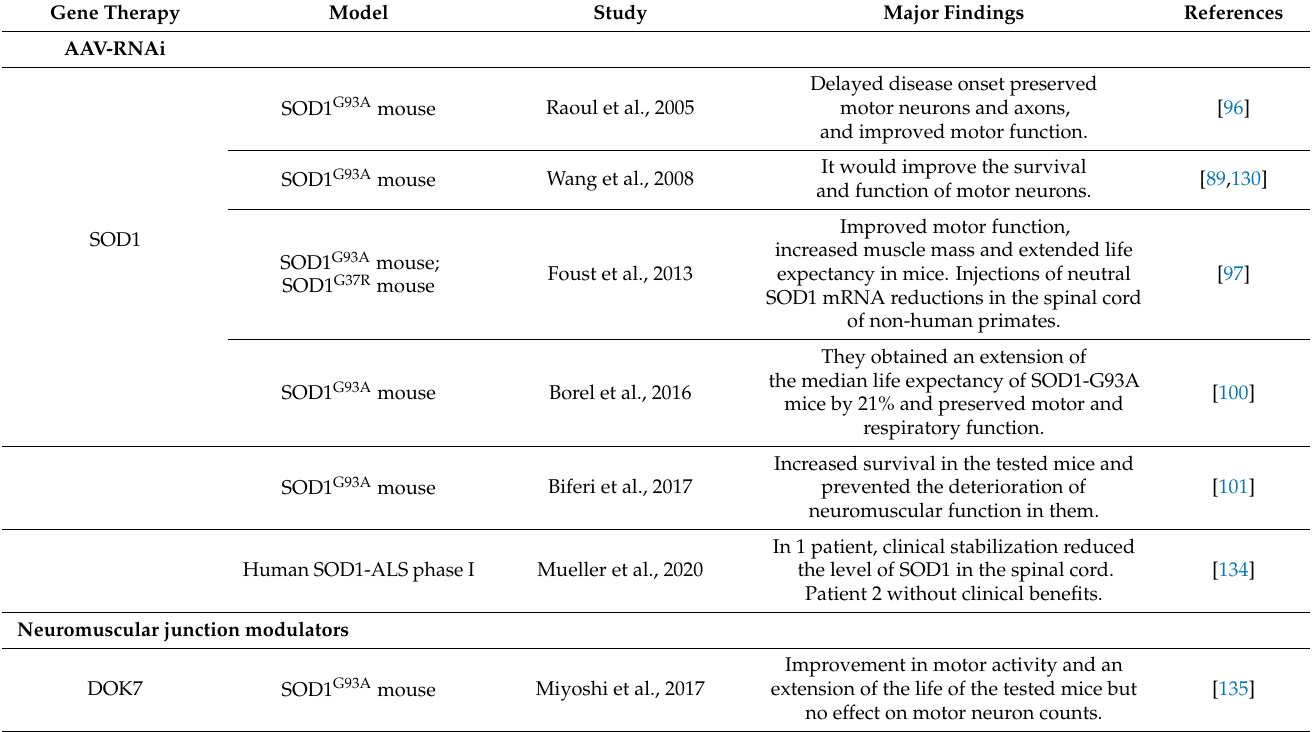
Table 3. Summary of research on gene targeting therapeutics mediated by viral